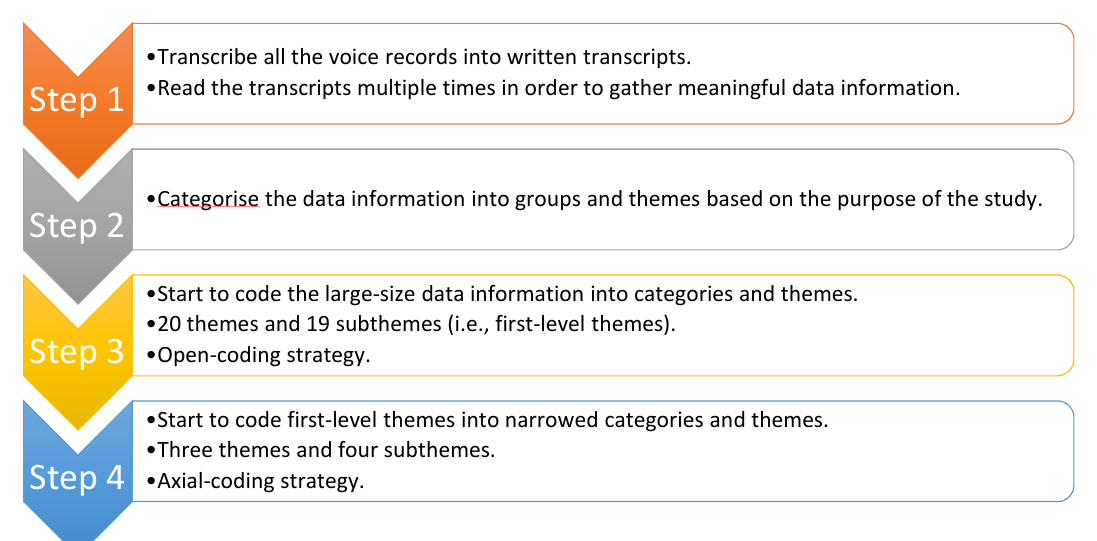
Figure 1. The procedure of the data analysis.